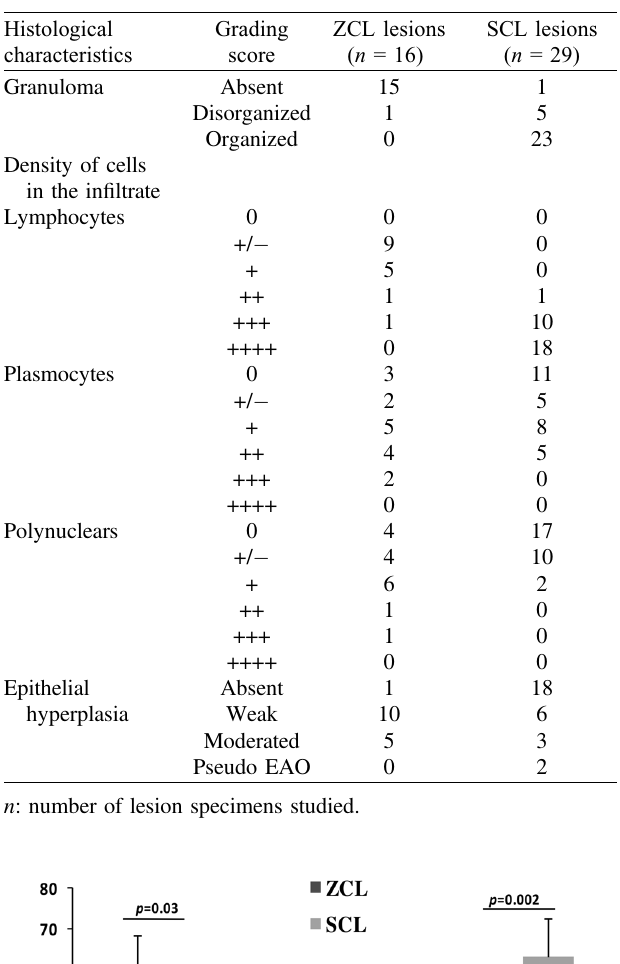
Table 1. Semi-quantitative results of the histological study of ZCL and SCL lesions.